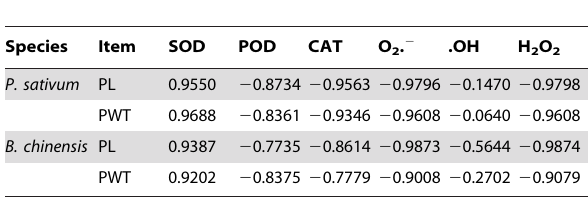
Table 2. Correlation coefficients between either pod length or pod wall thickness and either SOD activity, POD activity, CAT activity, or the level of either O 2. 2 , . OH, H 2 O 2 during pod